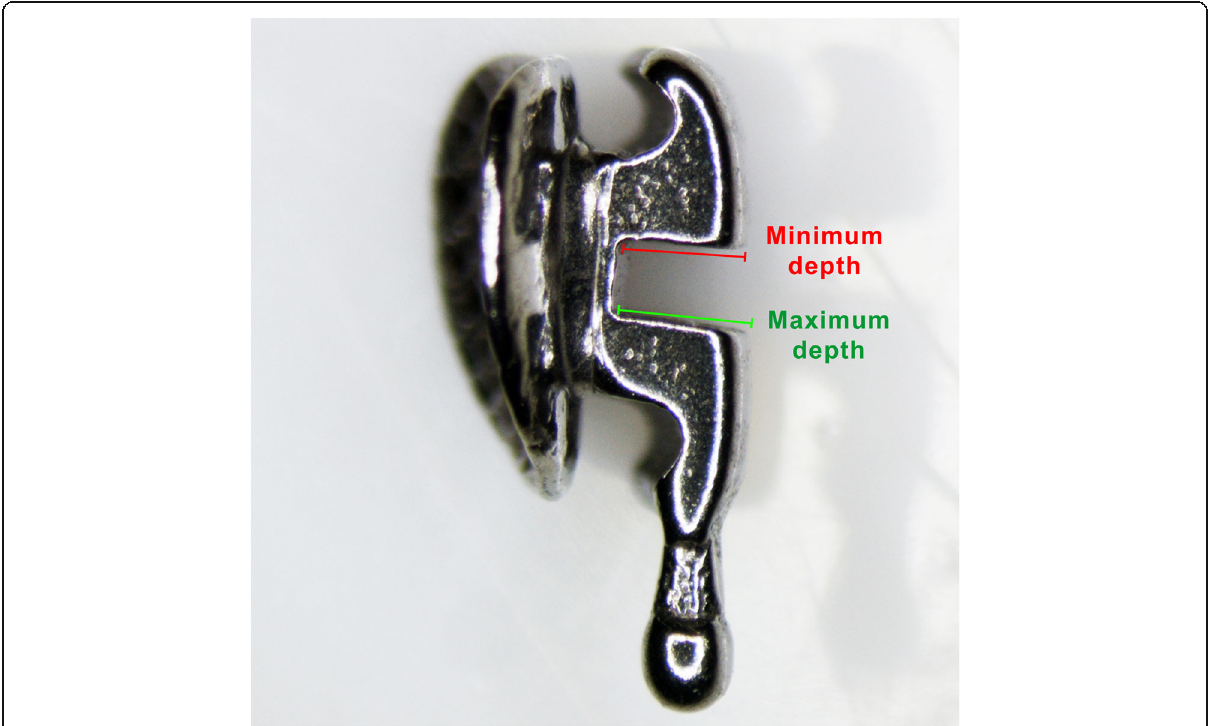
Fig. 3 Definition of the slots ’ maximum depth and minimum